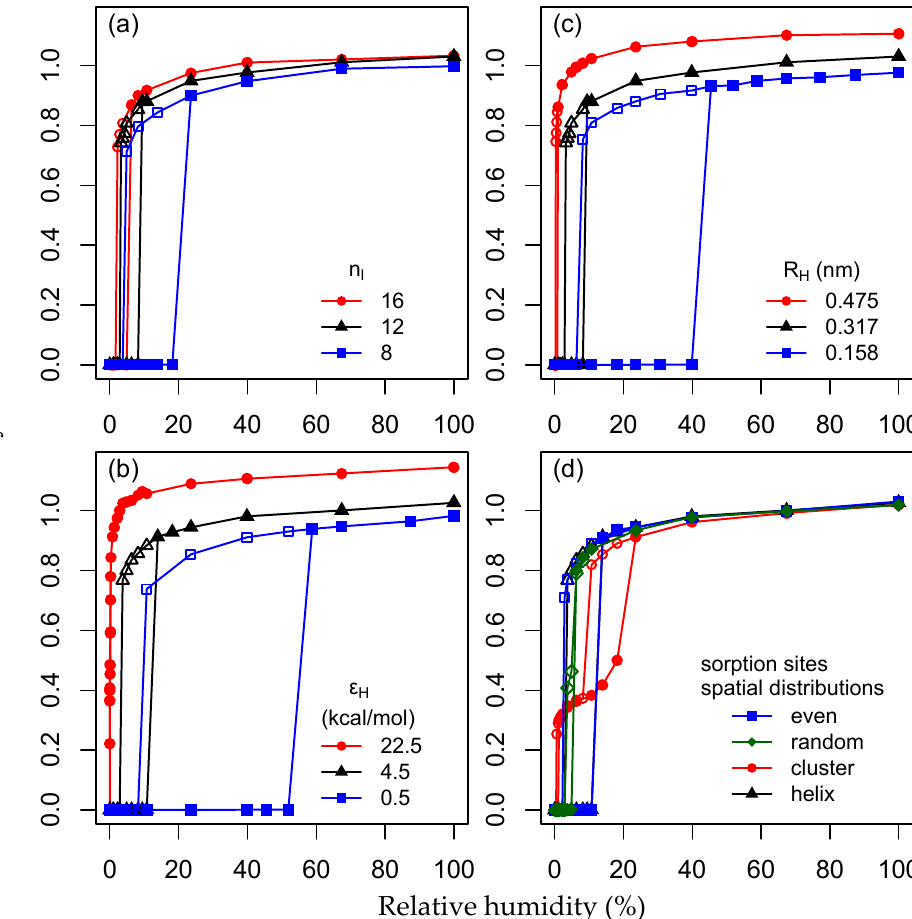
Figure 5. Simulated water sorption isotherms of 0.95 nm PW 1 pores at 25 °C with different sorption sites ( a ) number, ( b ) strength, ( c ) interaction range and ( d ) spatial distributions. solid symbols, adsorption; open symbols, desorption.